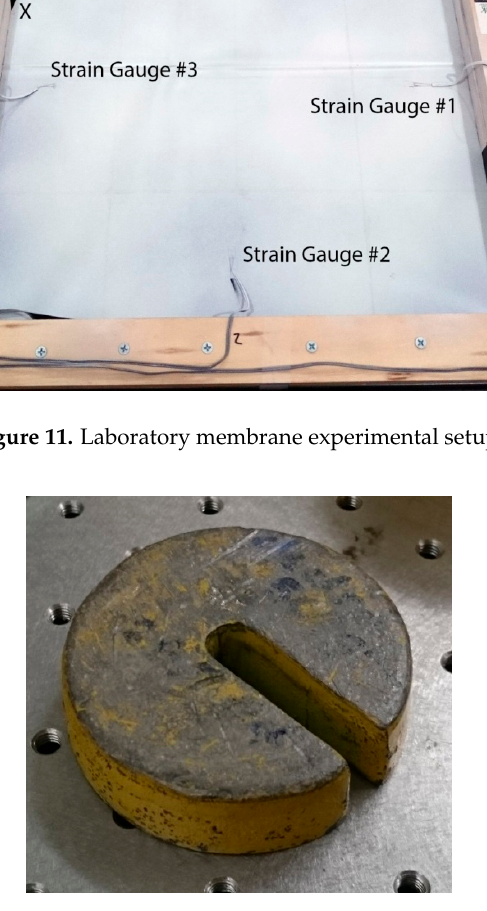
Figure 12. Spacer to be placed beneath the test membrane to simulate the formation of scum-berg. (72 mm diameter by 20 mm thick).